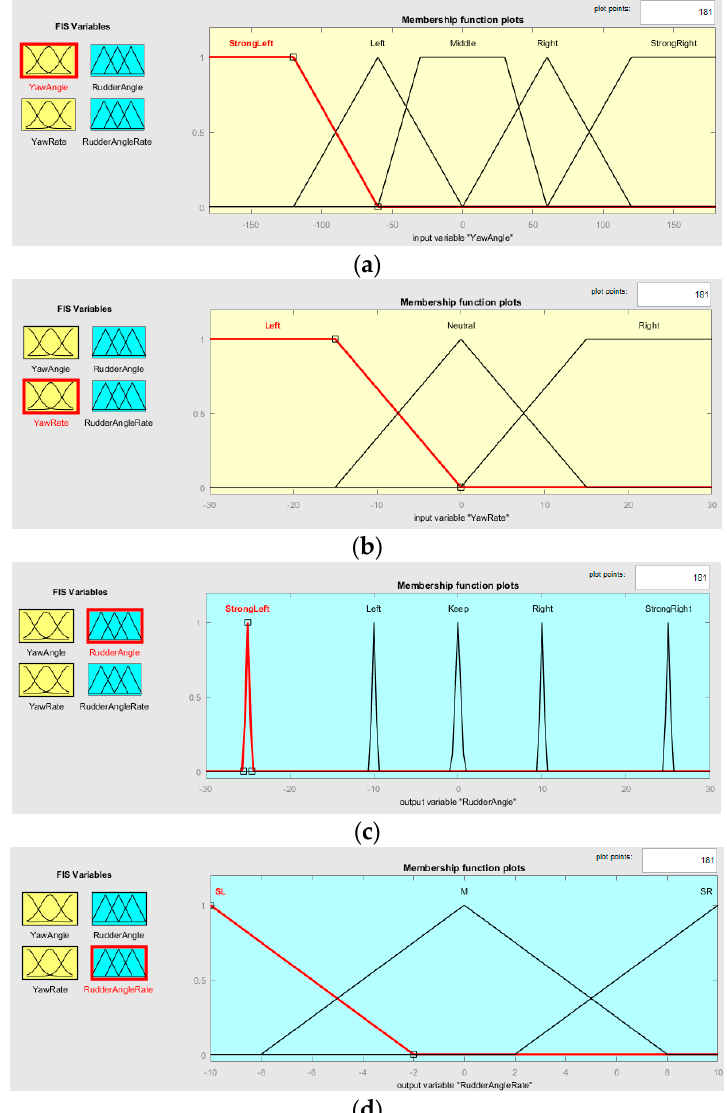
Figure 4. ( a ) Input variable 1—membership of yaw angle; ( b ) input variable 2—membership of yaw rate; ( c ) output variable 1—membership of the vertical rudder angle; and ( d ) output variable 2—membership of the vertical rudder angle